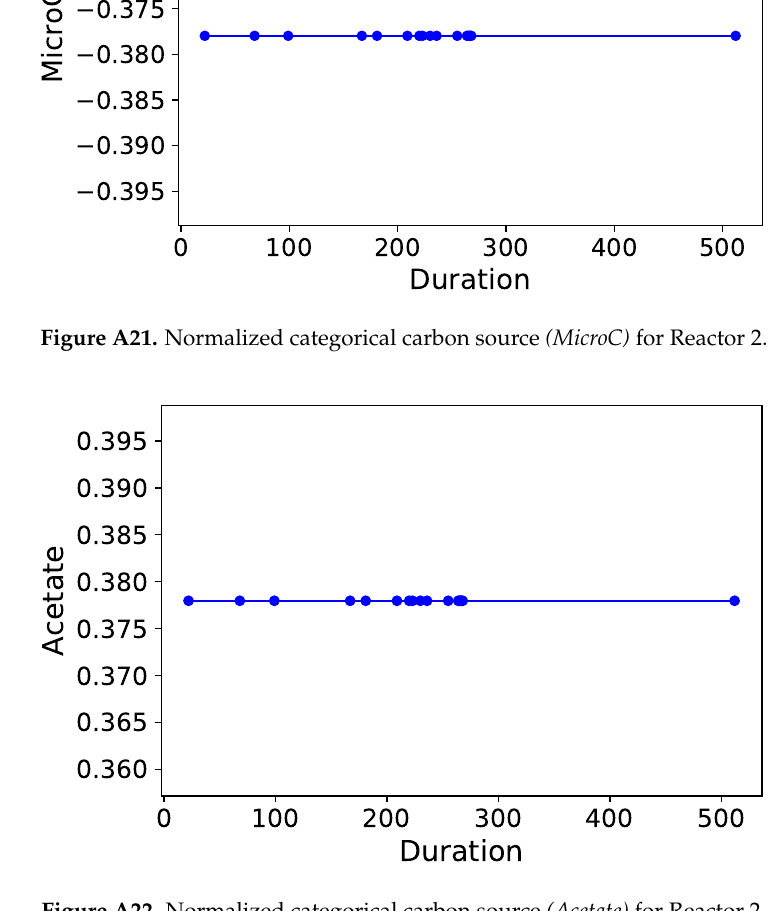
Figure A22. Normalized categorical carbon source (Acetate) for Reactor